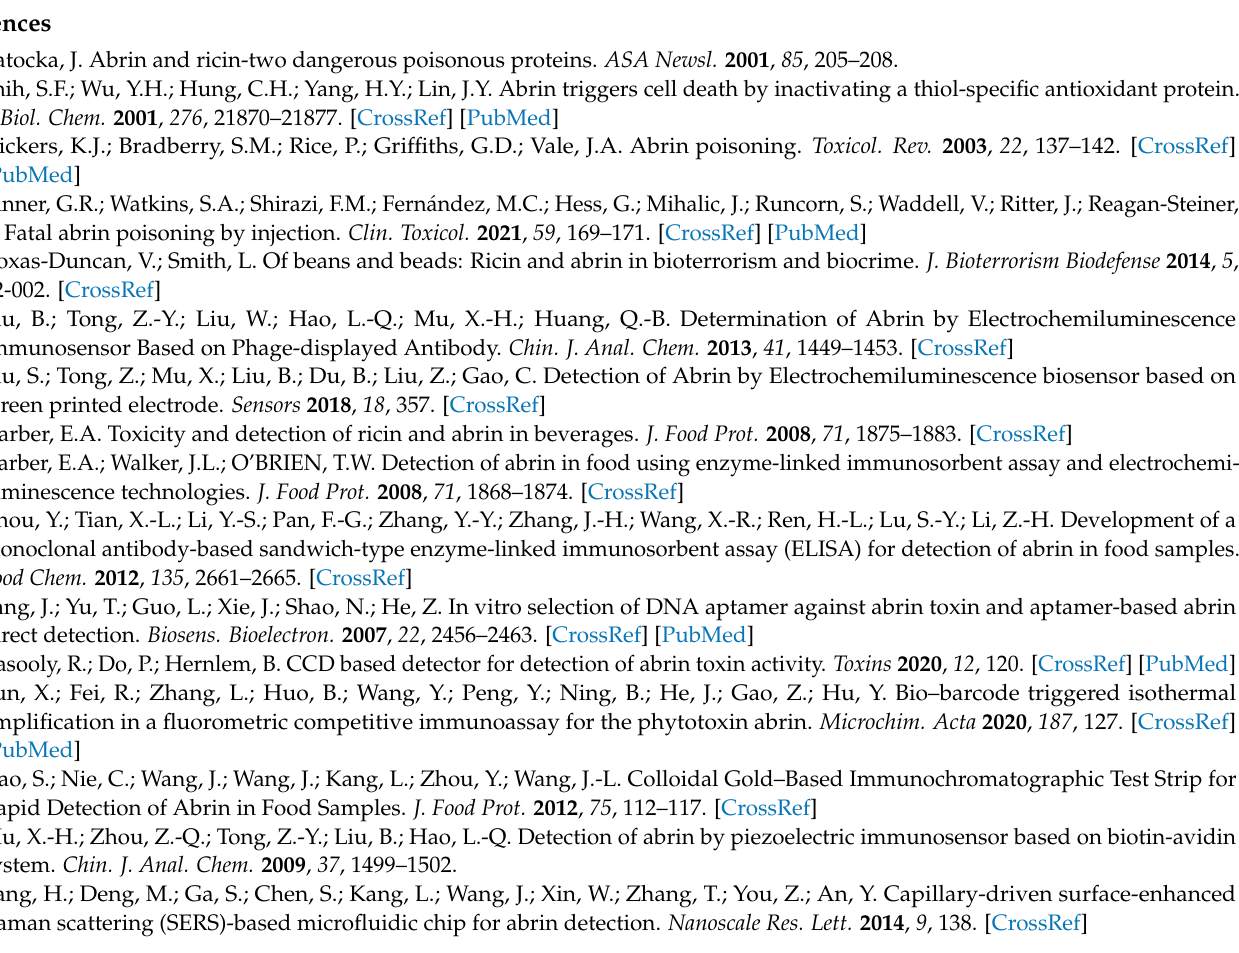
Figure S4: Schematic diagram of labeling ratio (Ru(bpy) 32+ and biotin) optimization principle; Figure S5. Stability test (ten cycles); Table S1: Measured values and reproducibility test (n =